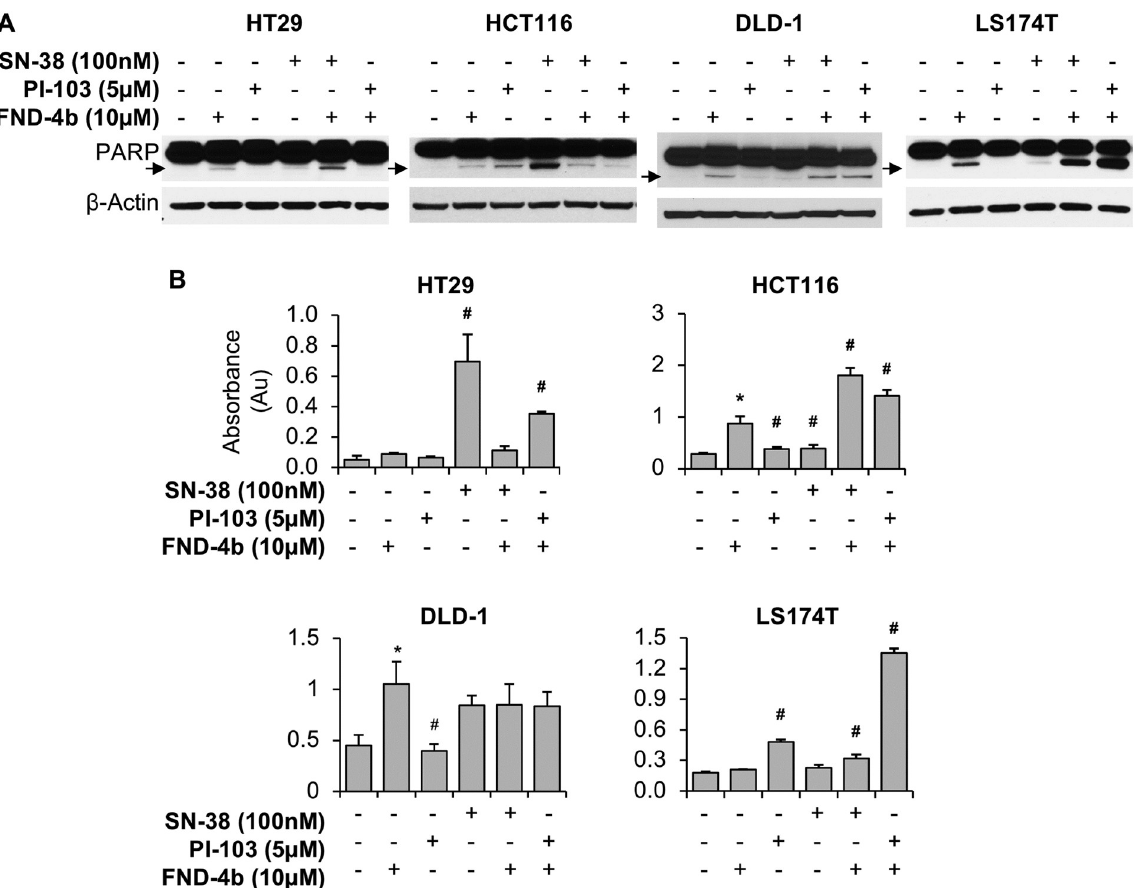
Fig 4. Apoptosis of commercial CRC cell lines treatment combinations. (A) Western blot analysis of commercially-available CRC cell lines treated with 10 μ M FND-4b, 5 μ M PI-103, and 100nM SN-38, alone and in combination versus untreated control (media alone) for 24h duration. PARP cleavage is indicated by an arrow; β -actin was used as a loading control. The images are representative of three independent experiments. In all CRC cell lines, PARP cleavage was increased as a result of FND-4b treatment compared to untreated control. (B) DNA fragmentation measured by Cell Death ELISA Assays of commercially-available CRC cell lines treated with 10 μ M FND-4b, 5 μ M PI-103, and 100nM SN-38, alone and in combination for 48h duration. Graphic representations are the mean ± SD of DNA fragmentation plotted as absorbance (Au); each measurement was performed with 3 replicates. � p < 0.01 vs. control and #p < 0.01 vs. FND-4b alone.